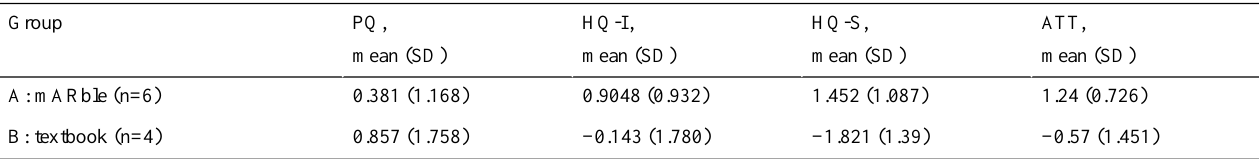
Table 1. Aggregated values calculated for the 4 qualities covered by AttrakDiff2: pragmatic quality (PQ), identification (HQ-I), stimulation (HQ-S), and attractiveness